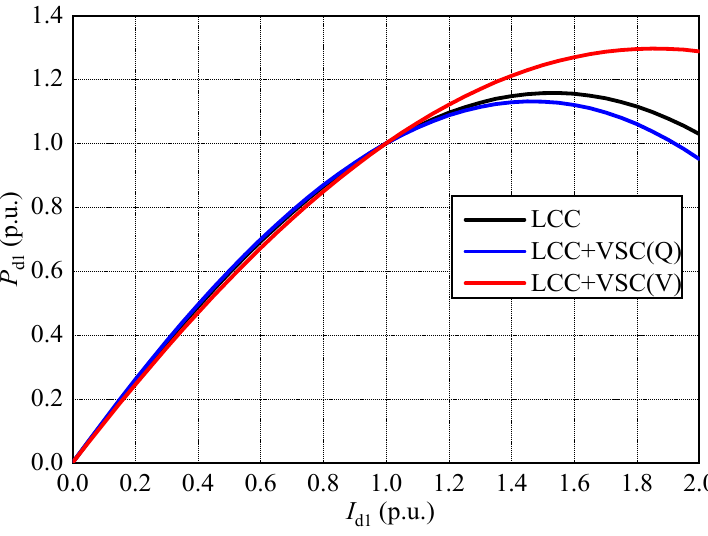
Figure 3. Maximum power curves of LCC-HVDC under different control modes. Table 1. Power stability indexes of LCC-HVDC at the rated point under different control modes. Control